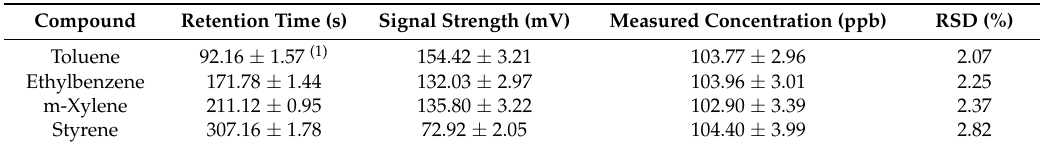
Table 5. Comparison of VOCs concentrations for precision.